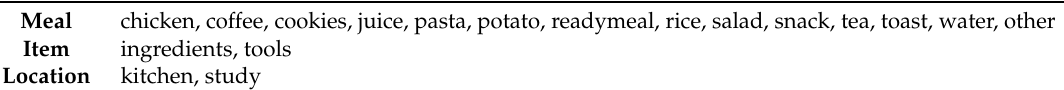
Table 4. Object sets in the